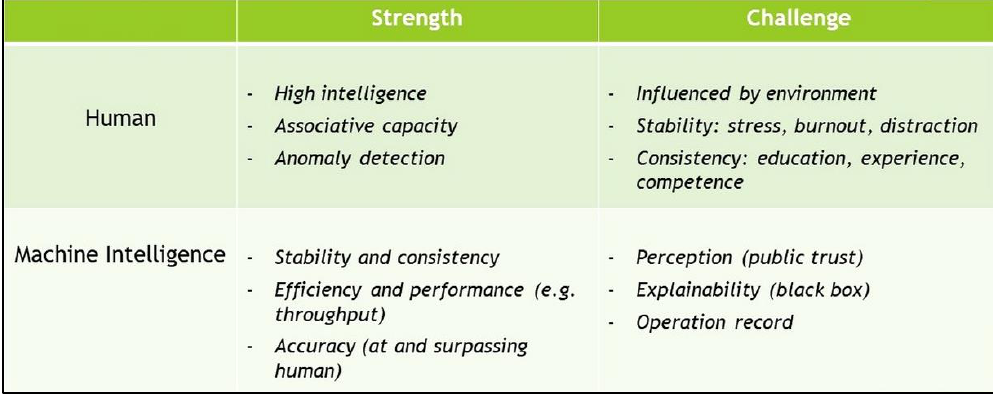
Figure 2. Human and machine intelligence: strengths and